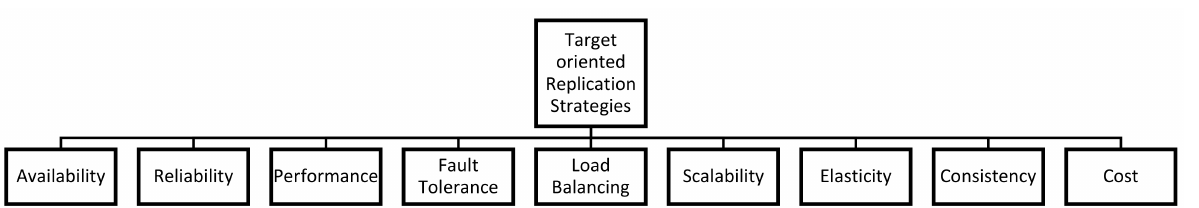
Figure 4. Demonstrates the classification of target-oriented replication strategies based on target